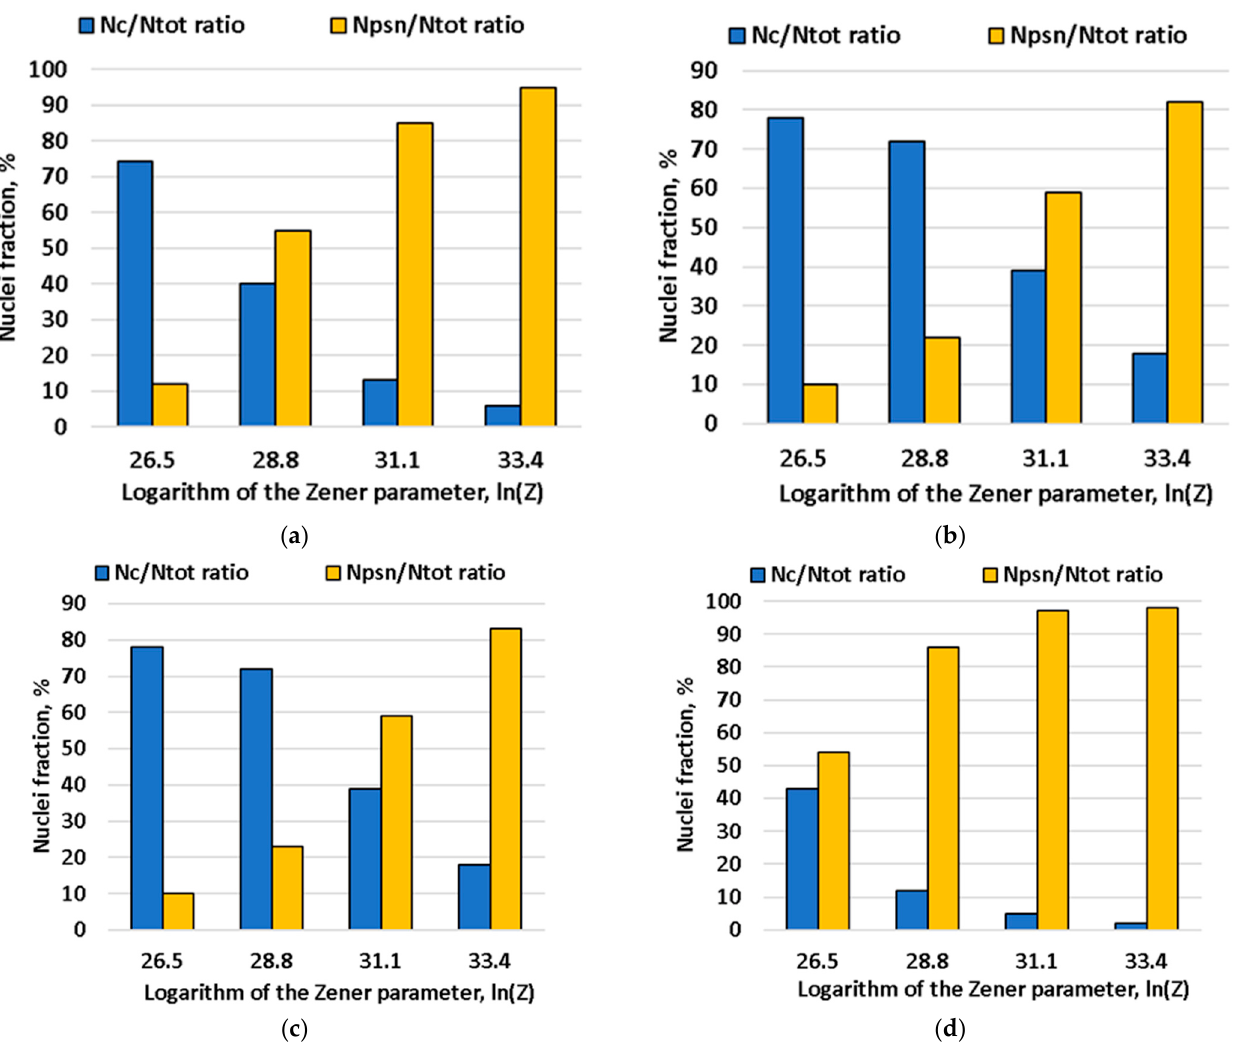
Figure 14. Changing t of N c subgrains-based nuclei and N PSN second-phase particles-based nuclei fraction depending on Zener-Hollomon parameter and alloy chemical composition: ( a ) alloy No. 1, ( b ) alloy No. 5, ( c ) alloy No. 8, ( d ) alloy No. 11.